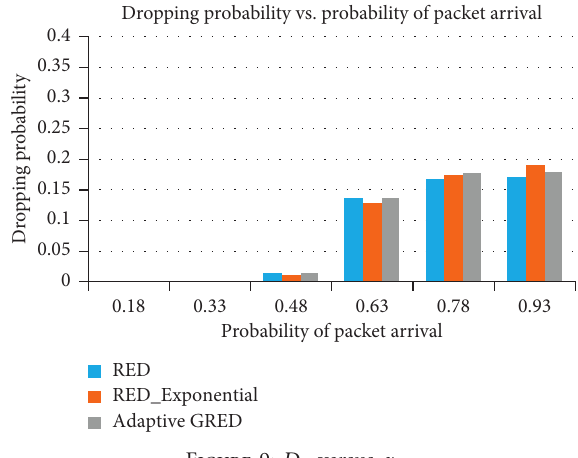
Figure 9: D p versus α .